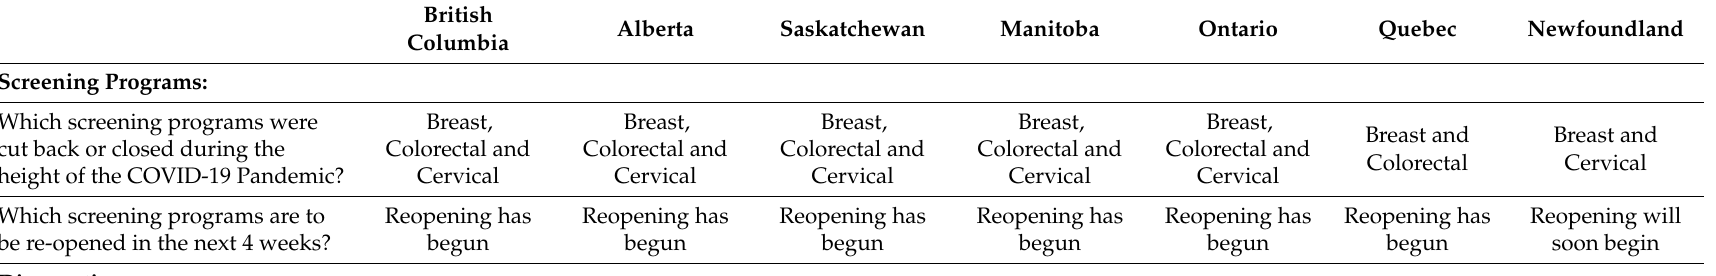
Table 1. Provincial responses to COVID-19 pandemic